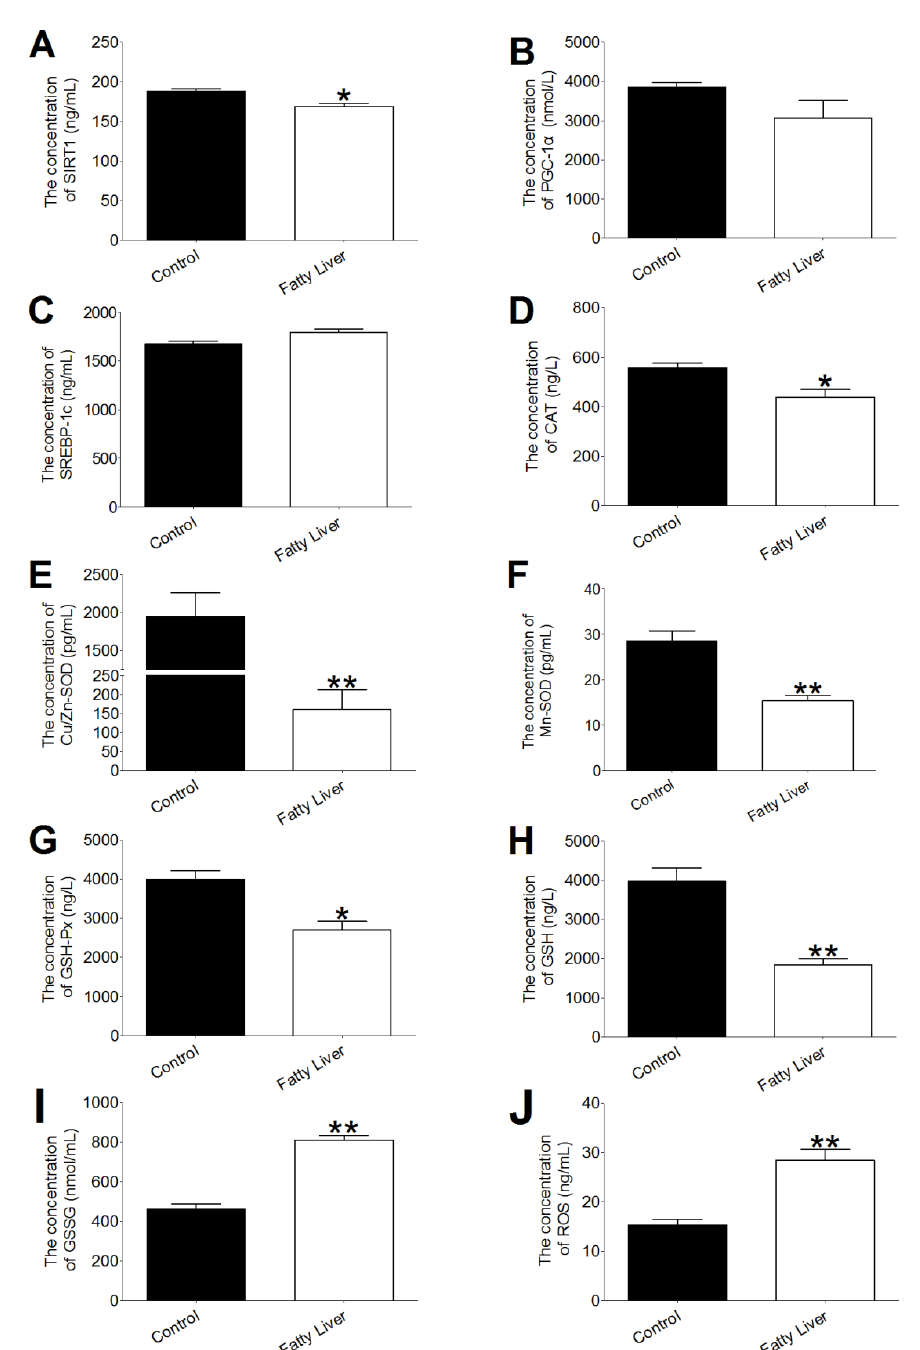
Figure 3. E ff ect of hepatic steatosis on the activities of hepatic sirtuin 1 (SIRT1), sterol regulatory element binding proteins (SREBP-1c), peroxisome proliferator-activated receptor γ coactivator-1 alpha (PGC-1 α ), catalase (CAT), copper-and zinc-containing superoxide dismutase (Cu / Zn SOD), manganese superoxide dismutase (Mn-SOD), glutathione peroxidase (GSH-Px) and the concentrations of glutathione (GSH), reduce glutathione disulfide (GSSG) and reactive oxygen species (ROS). E ff ect of lipid deposition on SIRT1, SREBP-1c and PGC-1 α concentrations in control (n = 6) and fatty liver (n = 6) group dairy cows ( A – C ); E ff ect of lipid deposition on antioxidant index concentrations in control (n = 6) and fatty liver (n = 6) group dairy cows ( D – H ); E ff ect of lipid deposition on oxidative indexes concentrations in dairy cows ( H – J ). The data presented are the mean ± SEM. * p < 0.05; ** p <